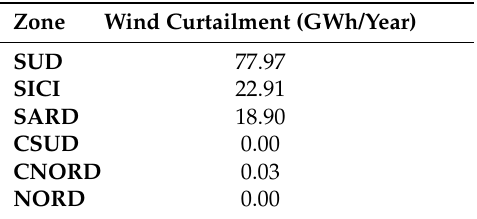
Table 7. Wind curtailment values in each zone, resulting from the simulation.